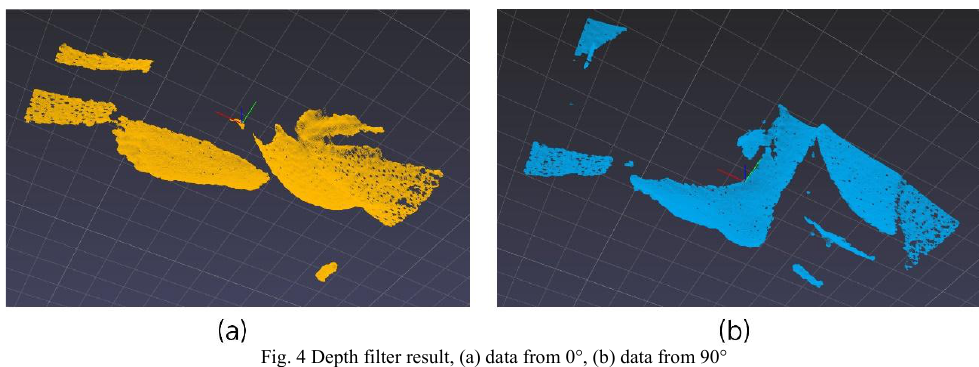
Fig. 4 Depth filter result, (a) data from 0°, (b) data from